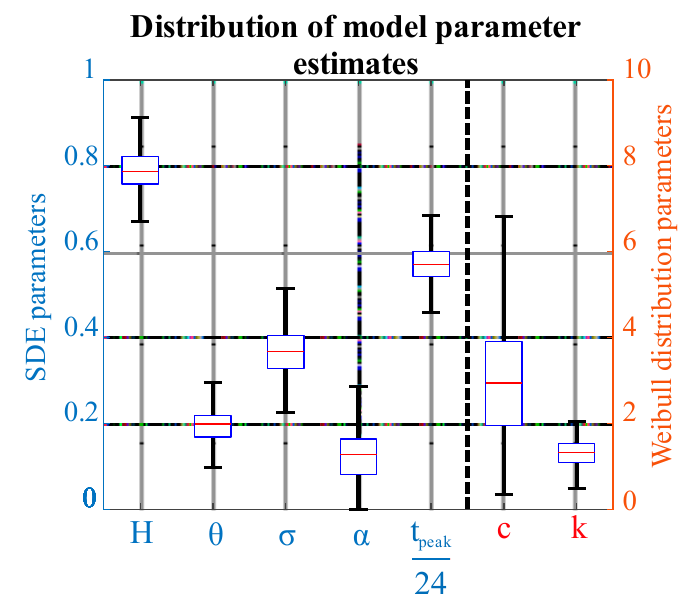
Figure 3. Boxplot of estimated model parameters.